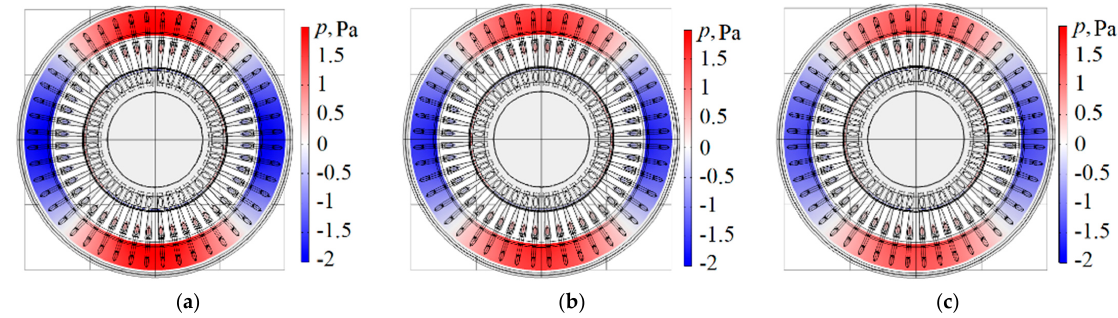
7%, k 2 u = 8% for case I g 3 = 8.8 A , I g 5 = 3.3 A and k 0u = 23%, k 2 u = 18% for case I g 3 = 15.4 A , I g 5 =